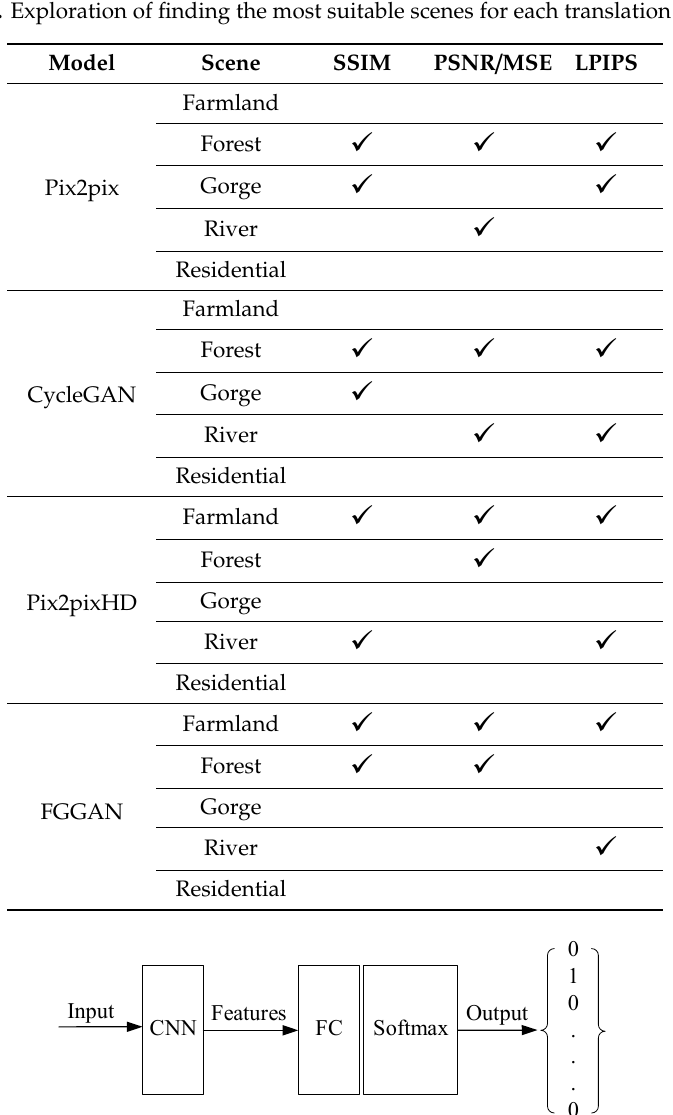
Figure 10. Relationships between feature extraction and image classification. Convolutional neural networks (CNN) variants include 18-layer ResNet, Inception, SqueezeNet and 19-layer visual geometry group network(VGG).